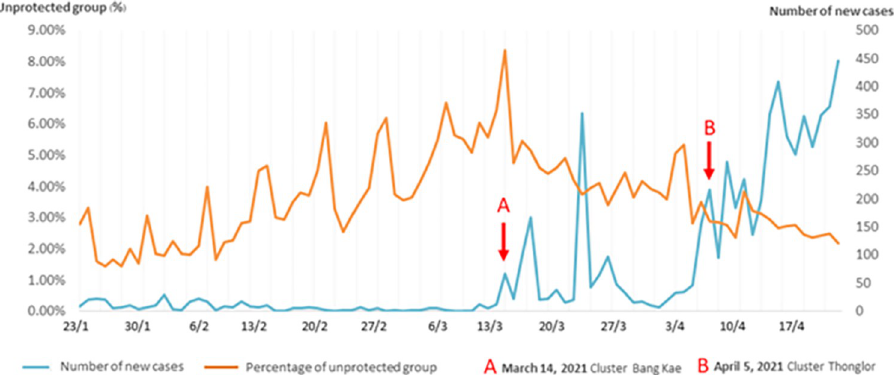
Fig 3. Correlation between the unprotected group and reported new COVID-19